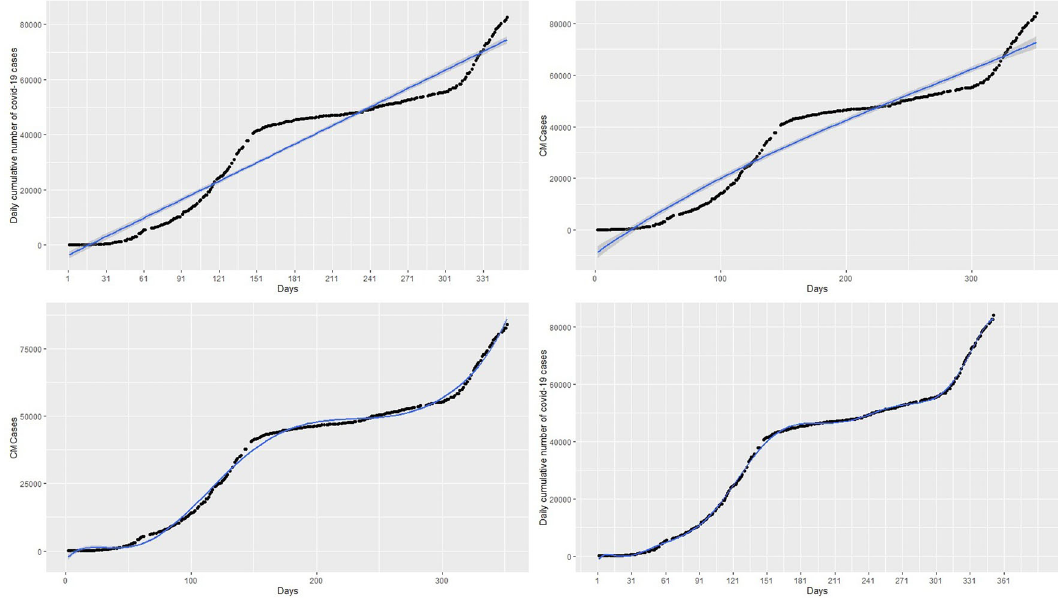
Figure 3. Fits of the linear regression model (top-left panel), polynomial of degree 3 (top-right panel), polynomial of degree 7 (bottom-left panel), and polynomial of degree 11 (bottom-right panel) to the cumu- lative cases.